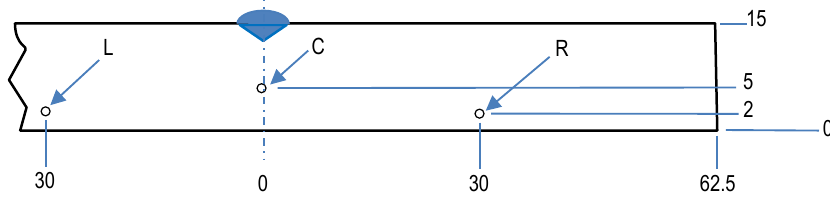
Figure 1b: Setup for temperature test. Three thermocouples are located at left (L), right (R) and below the center (C) of a weld. All dimensions are in millimeters.